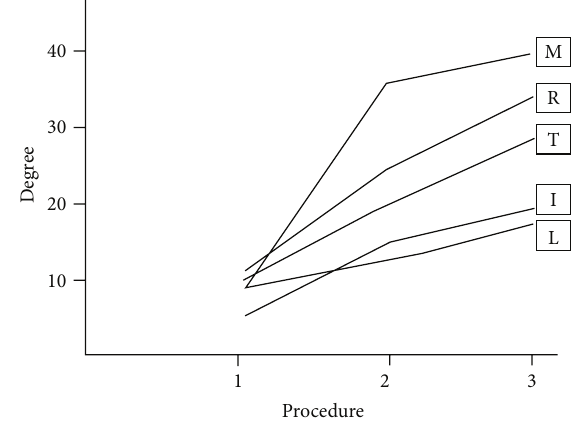
Figure4:Thegraphicalappearanceoftheincreasesoftheflexorten- dons’ entrance angles to the A1 pulley according to the procedures 1, 2, and 3. The maximal increase is detected in the middle finger from procedure 1 to procedure 2. The minimal increase is detected in little finger. M: middle finger, R: ring finger, T: thumb, I: index finger, and L: little